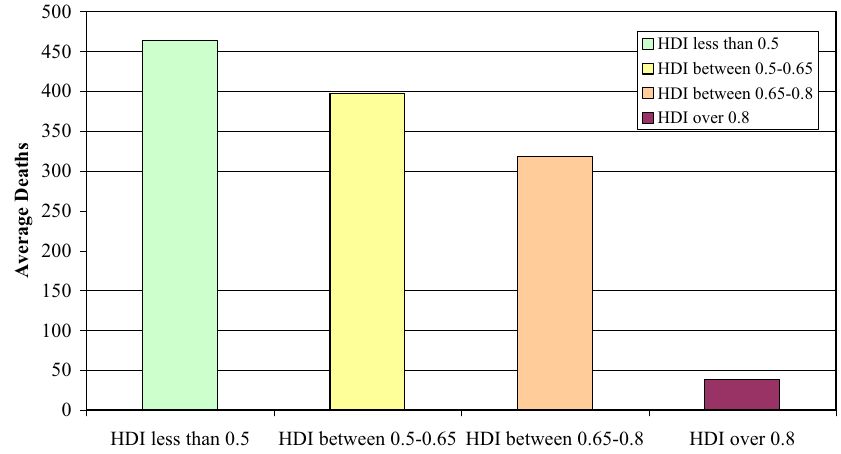
Fig. 10. Median deaths per CATDAT v5.024 damaging earthquake for a particular Human Development Index bracket.